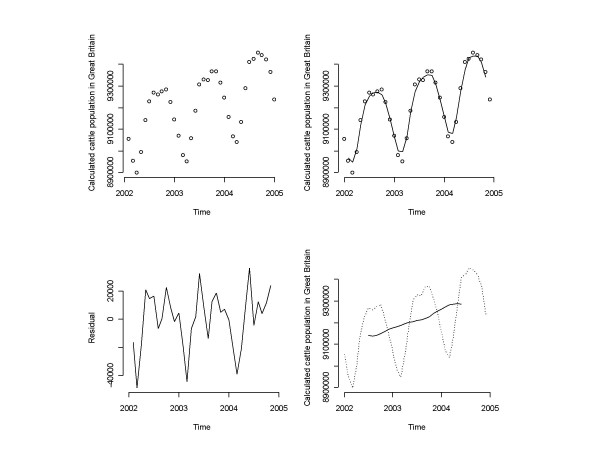
Time series for the calculated cattle population in Britain per month reported by BCMS over the period 1st Jan 2002 and 31st Dec 2004. (a) Raw monthly data (b) 3-point moving average (raw data shown as unconnected symbols) (c) Residuals after accounting for the 3-point moving average (d) 13-point moving average (raw monthly data shown as unconnected symbols).